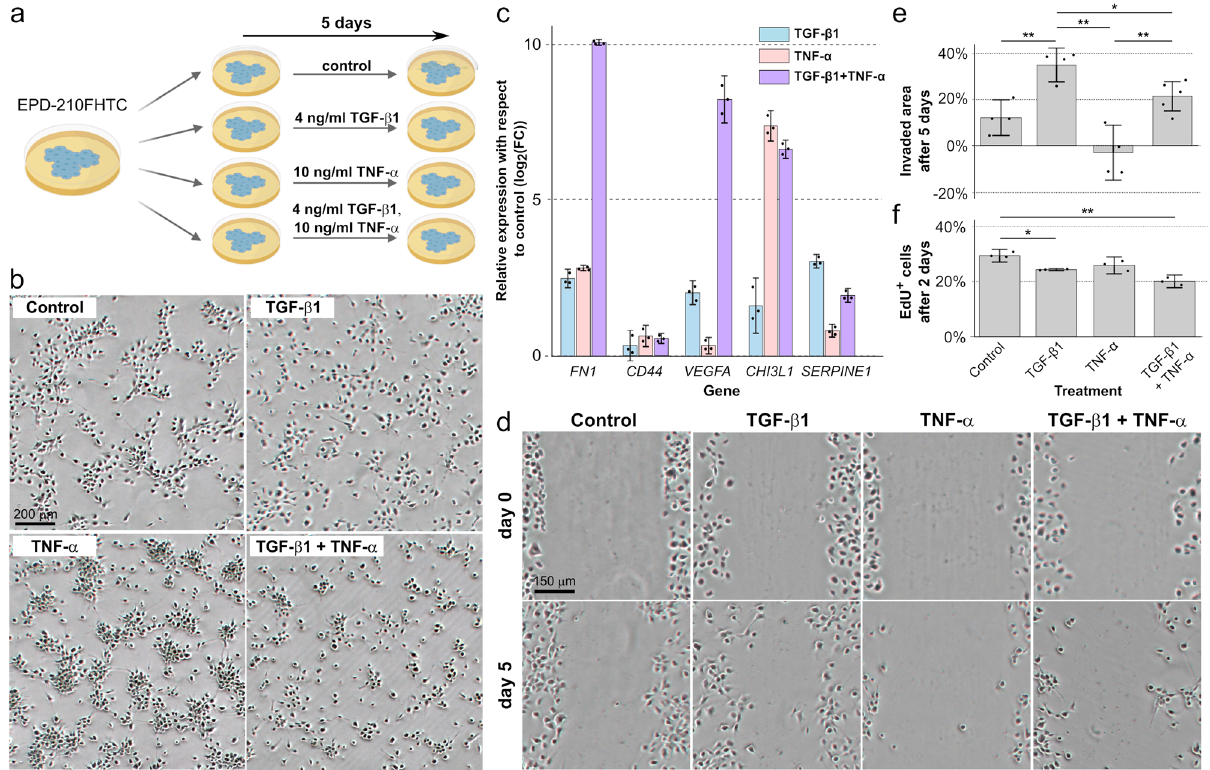
Fig. 5 Pro-in fl ammatory cytokines induce the expression of mesenchymal-like genes and diverse cellular phenotypes in a patient-derived PFA cell model. a Experimental design. The PFA primary cell line EPD-210FHTC was cultured in the presence or absence of TGF- β 1 and/or TNF- α for 5 days. The experiment was performed in three biological replicates. b Image of the EPD-210FHTC cells after the 5-day culture, for each of the treatments. TGF- β 1 is required for the cells to acquire a mesenchymal phenotype, whereas treatment with TNF- α potentiates the formation of 3D colonies. c Average change in the gene expression level of MLC-speci fi c markers with respect to the no-treatment control after 5 days of treatment. Gene expression levels were pro fi led by RT-qPCR. Both TGF- β 1 and TNF- α induce the upregulation of MLC markers, but the relative expression levels of FN1 and CHI3L1 strongly depend on the particular treatment. Error bars indicate 90% con fi dence intervals. d Cell migration assay. An example of the same gap at day 0 and day 5 is shown for each condition. Treatment with TGF- β 1 leads to a substantial increase in the invasive potential of the cells. e Average fraction of the area invaded by the cells after 5 days in the cell migration assay across four biological replicates (two-sided t -test; * p value (cid:3) 0 : 05, ** p value (cid:3) 0 : 01). Error bars indicate 90% con fi dence intervals. f Cell proliferation assay by EdU incorporation. The average proportion of EdU + cells after 2 days of treatment is shown for each of the experimental conditions. The cell proportions in each condition were compared to the cell proportion in the no-treatment control across three biological replicates using a two-sided t -test. Treatment with TGF- β 1 and/or TNF- α leads to a small reduction in cell proliferation (** p value (cid:3) 0 : 01, *** p value (cid:3) 0 : 001). Error bars indicate 90% con fi dence intervals. Source data and numeric p values are provided in the Source Data fi